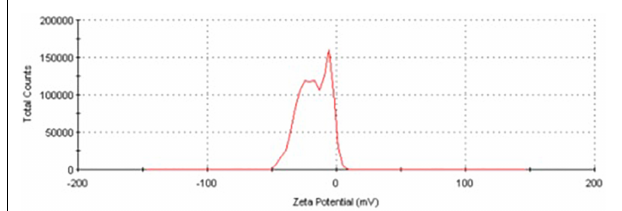
FIGURE 8 | Zeta potential distribution of AgNPs produced by A. terreus BA6 under near optimum conditions.